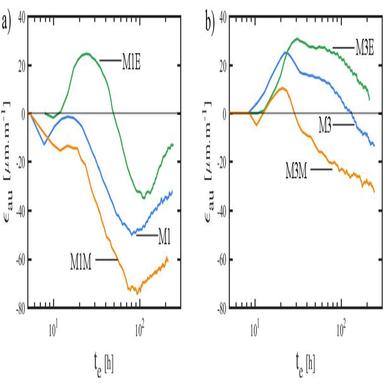
Autogenous deformation versus equivalent time for a) CEMI-based mortars and b) CEMIII/A-based mortars.